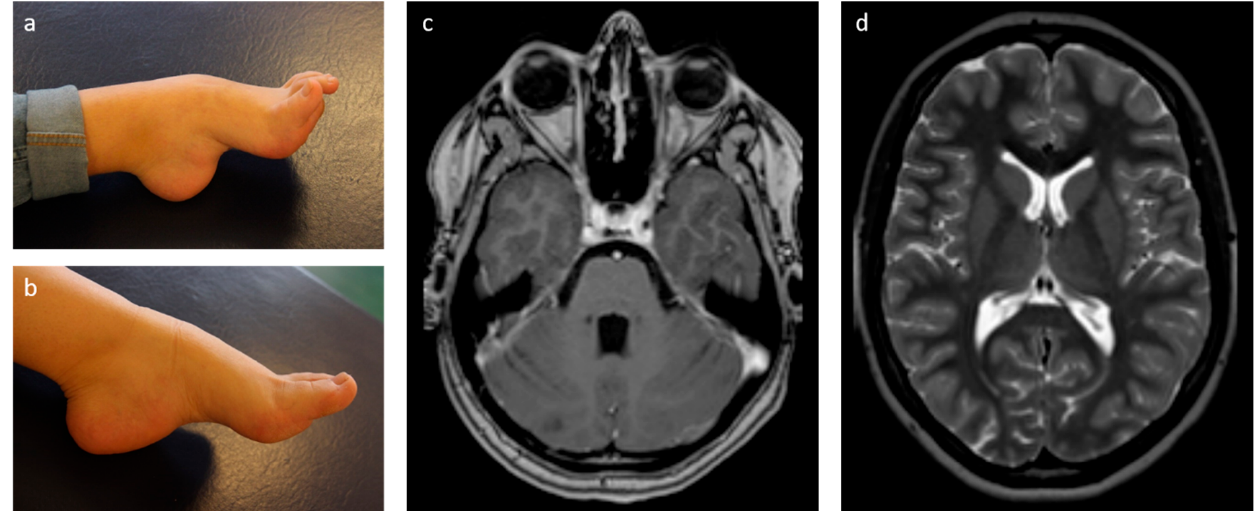
Figure 1. Pes cavus deformity in daughter ( a ) and mother ( b ) with a pathogenic variant in SAMD9L . ( c ) Cerebral MRI of the daughter at the age of 15 years showed some minimally accentuated cerebellar fissures on axial T1 weighted images. ( d ) The supratentorial brain was unremarkable according to age as shown on the axial T2 weighted images.